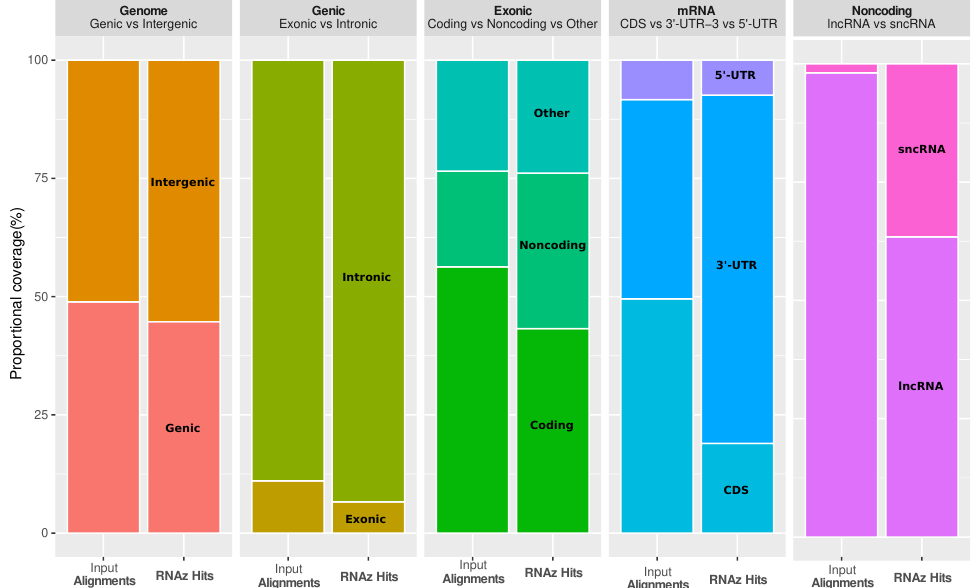
Figure 3. Coverage of different genomic contexts by input alignments and high-confidence loci, respectively. High-confidence loci are slightly depleted in genic vs intergenic regions and in exonic vs intronic regions. They are strongly enriched (1.6-fold) in noncoding exons, which, in turn, is due to the enrichment in the 3’-untranslated regions (3’-UTRs) (1.7-fold) of messenger RNAs (mRNAs). Short non-coding RNAs (sncRNA) contain the classic highly structured small RNAs, such as microRNAs and small nucleolar (snoRNAs), and are strongly enriched compared to long non-coding RNAs (lncRNA). CDS: Coding